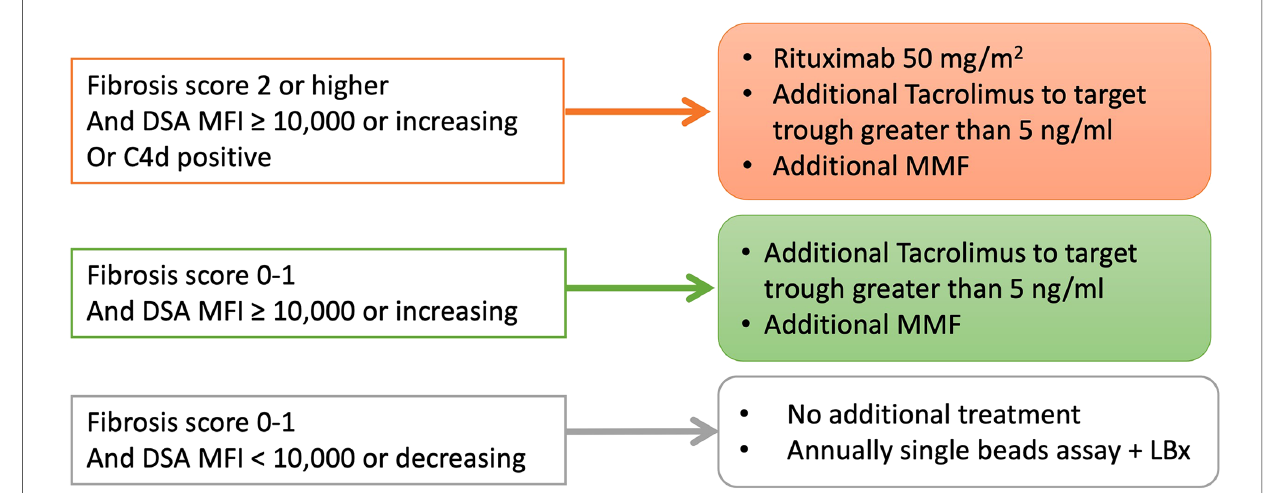
FIGURE 5 The treatment strategies for pediatric LT patients with post-transplant DSA in our institute since 2015. LBx, liver biopsy.